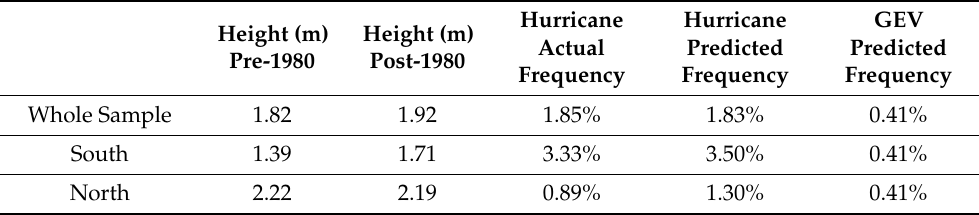
Table 2. Simulation of new forecasting